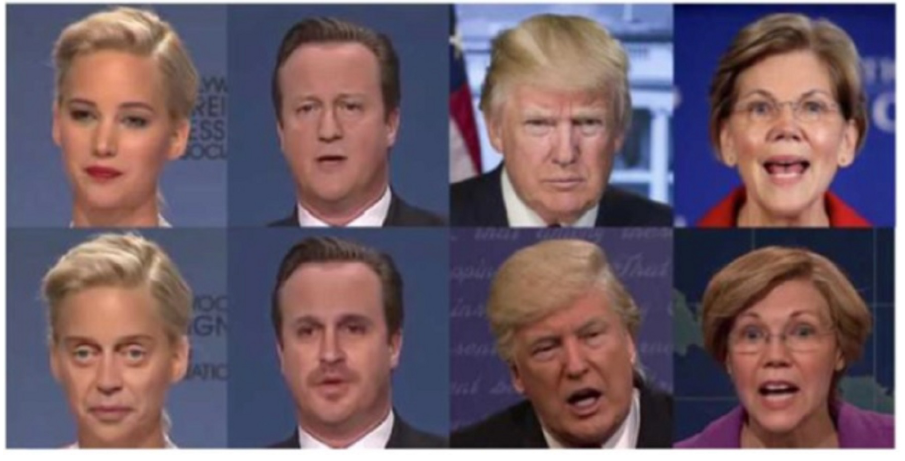
Figure 3. Examples of original and deepfake